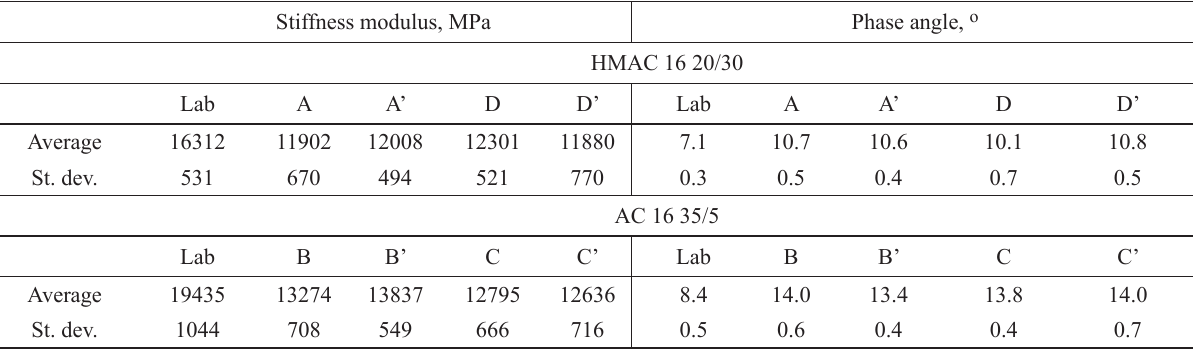
Table 3. Stiffness modulus and phase angle for mixes AC 16 W and HMAC 16